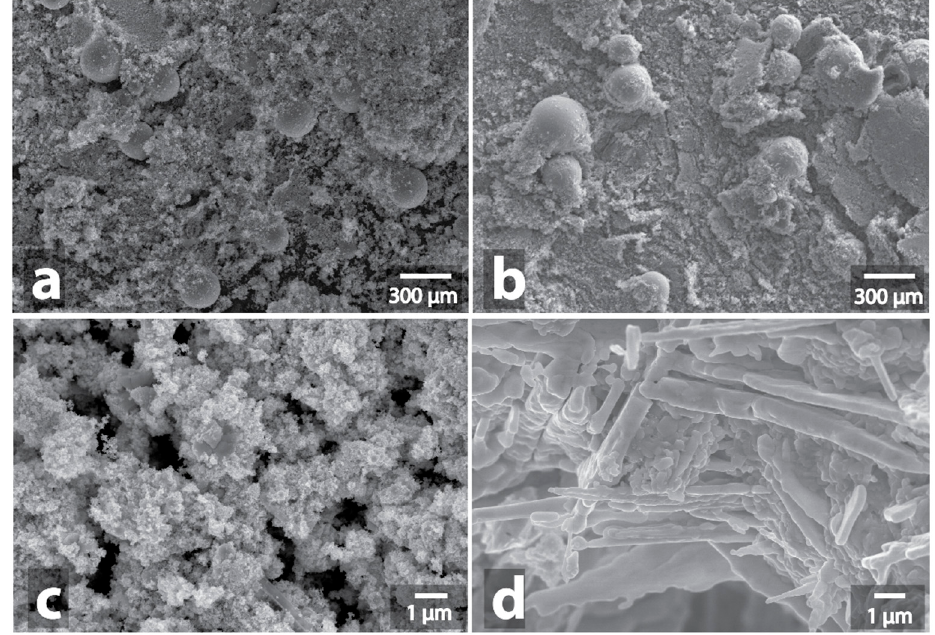
Figure 10. SEM image of initial Cr-C powder ( a ) and SEM image of Cr-C powder after MW-treatment ( b ), initial W-V-C powder ( c ) and SEM image of W-V-C powder after MW-treatment ( d ). Significant changes in morphology after microwave treatment were detected only in the case of W-V-C sample (Figure 10c,d, Figures S91–S102, Figure S214). Initially, the powder consisted of nanosized irregularly shaped units with an average diameter of about 17 nm. After